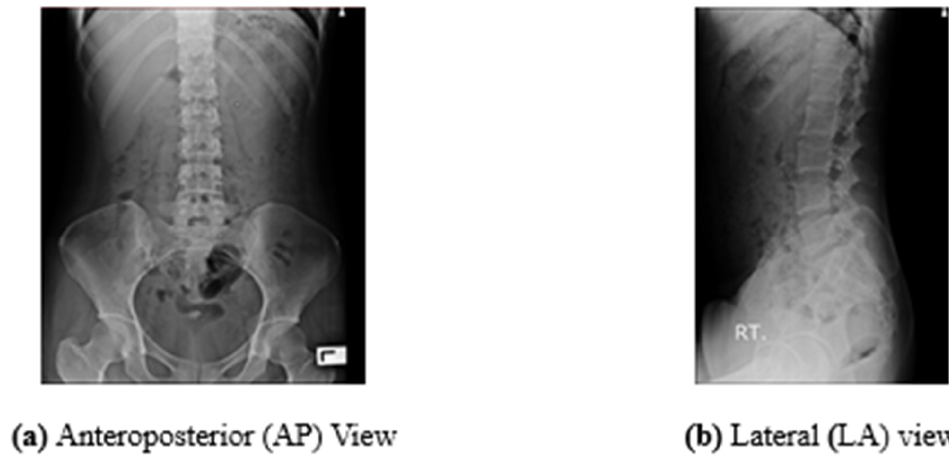
Figure 4. X-ray images in AP view ( a ) and Lateral view ( b )